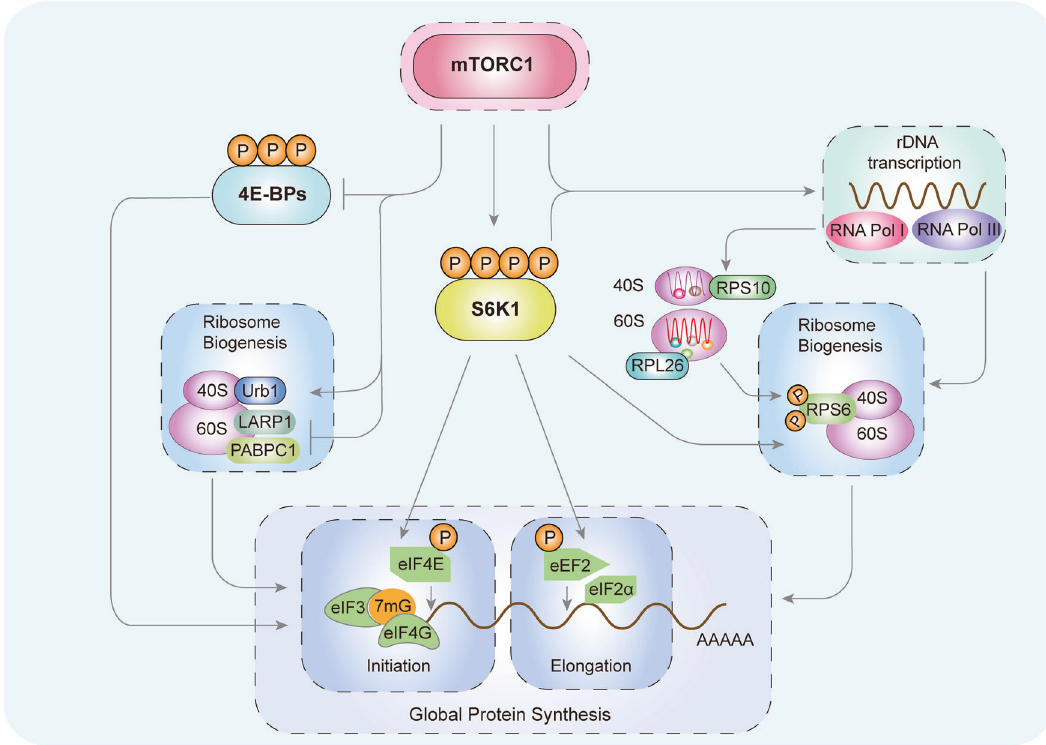
Fig. 2 mTORC1 and ribosome biogenesis. Through phosphorylation, mTORC1 activates S6K1, which enhances rDNA transcription. mTORC1phosphorylates RPS6 to promote the synthesis of ribosomal 40S subunits, actively regulates the formation of RPS10 and RPL26, and promotes the initiation and elongation of mRNA through eIF4E and eIF2 α , respectively. mTORC1 also phosphorylates and inactivates 4E-BPs to induce translation initiation. The RP assembly factor Urb1 is a downstream target of mTORC1 signaling. mTORC1 inhibits the binding of LARP1 and PABPC1 to promote mRNA translation and protein synthesis. mTORC1 mammalian target of rapamycin C1, rDNA ribosomal DNA, S6K1 S6 kinase 1, 4E-BP 4E-binding